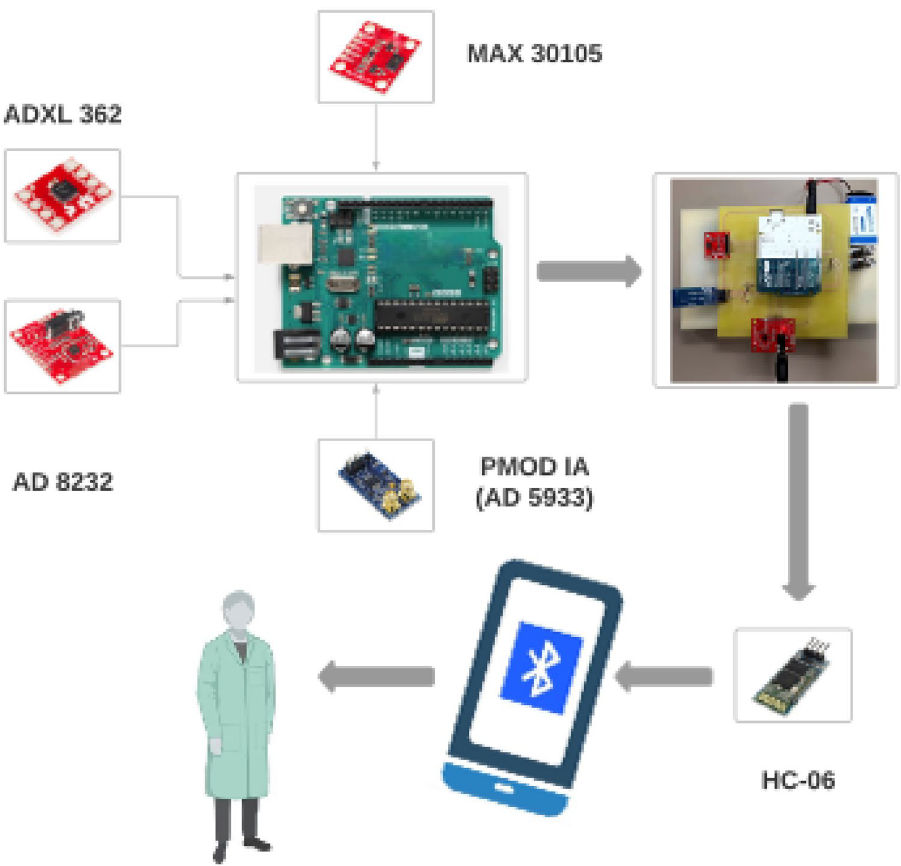
Figure 1. Block diagram of the operation of the HWD for HF prediction showing different sensors used for sensing multiple parameters along with the integrated final